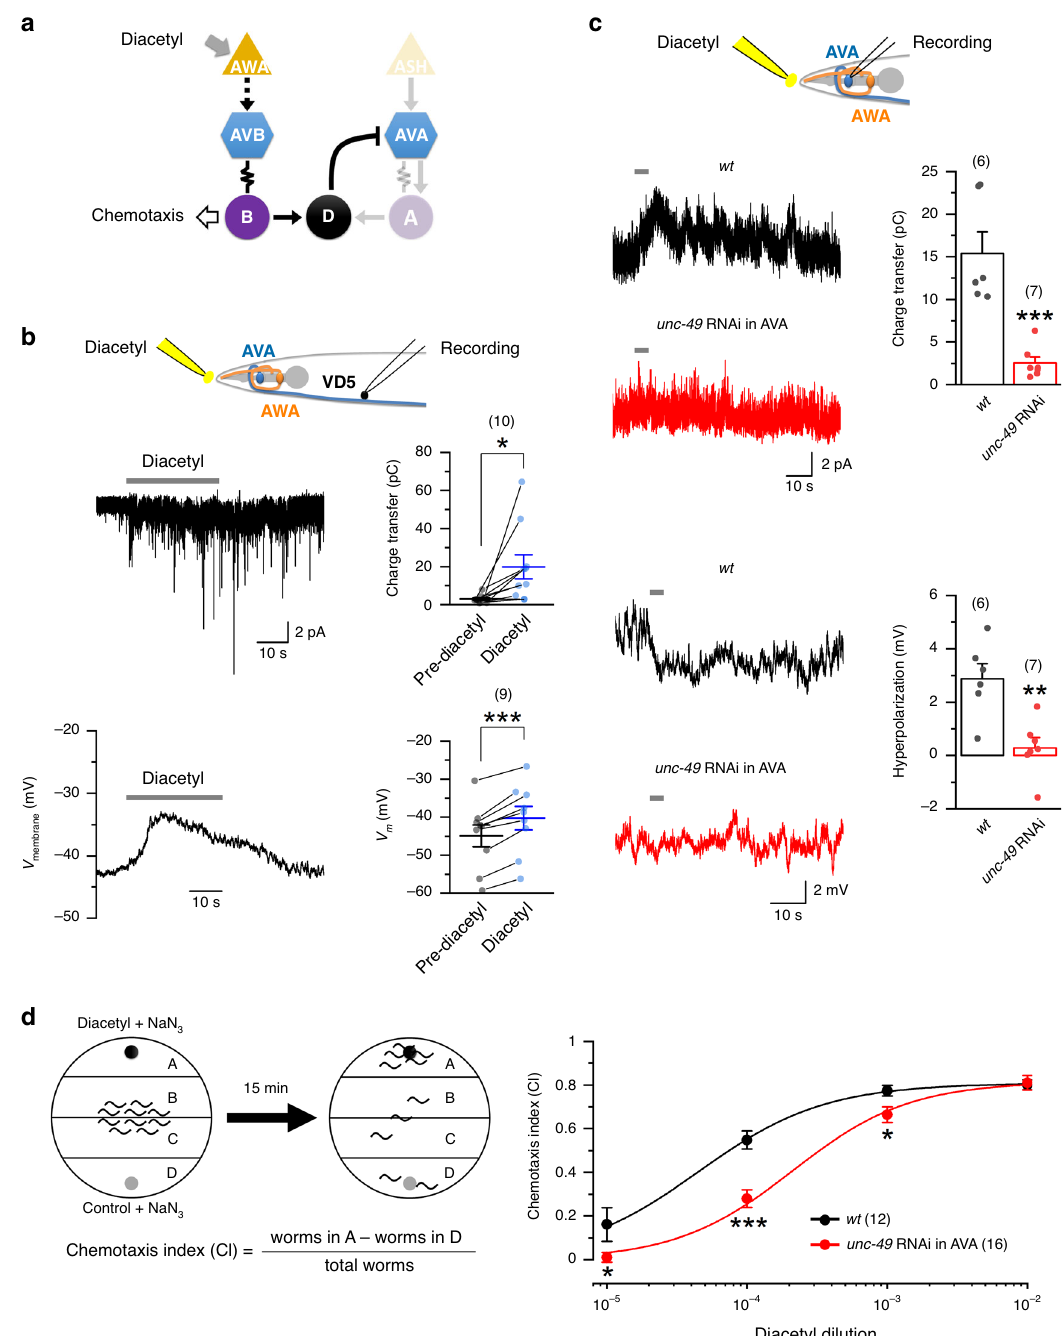
Fig. 5 The D-AVA circuit enhances chemotaxis toward diacetyl. a A simpli fi ed wiring diagram for diacetyl chemotaxis. b Diacetyl caused inward current in VD5 and depolarization of VD5. Compared with Pre-diacetyl, p = 0.024 charge transfer, and 0.000 V m . c Diacetyl caused outward current in AVA and hyperpolarization of AVA in wild-type ( wt ) but not AVA-targeted unc-49 RNAi strain. Compared with wt , p = 0.000 charge transfer, and 0.003 hyperpolarization. d AVA-targeted unc-49 RNAi reduced diacetyl chemotaxis response. Left: diagram showing the chemotaxis assay. At the beginning of each assay, a drop of diacetyl and NaN 3 mixture and a drop of diacetyl solvent and NaN 3 mixture were spotted on opposite sides of a nematode culture plate (6-cm diameter), and 10 – 15 worms were placed in the middle of the plate. Chemotaxis index was calculated as shown. Right: diacetyl concentration and chemotaxis index curves of wt and AVA-targeted unc-49 RNAi. Compared with wt , p = 0.043, 0.000, 0.023, and 0.839 at the four increasing glycerol concentrations, respectively. In b and c , the horizontal gray lines indicate the times of diacetyl application. Diacetyl (1:1000 dilution) was applied to the vicinity of the nose through a puf fi ng pipette. Statistically signi fi cant differences from pre-diacetyl ( b ), wt ( c ), and wt at identical diacetyl concentrations ( d ) are indicated by asterisks indicate statistically signi fi cant difference (* p < 0.05, ** p < 0.01, *** p < 0.001) compared with pre-diacetyl or wt based on either paired two-sided t -test ( b ) or unpaired two-sided t -test ( c, d ). The numbers inside brackets indicate sample size ( n ). n = numbers of independently recorded cells in b and c , but numbers of individual worms in d . Data are presented as mean values ± SEM. Source data are provided as a Source data fi